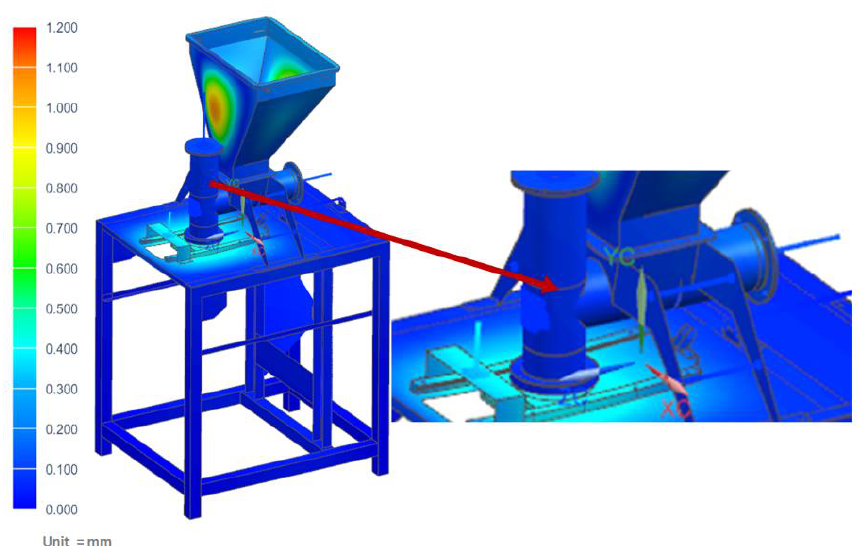
Figure 14. Displacement map of the molding module: pusher of the horizontal dispenser is blocked.